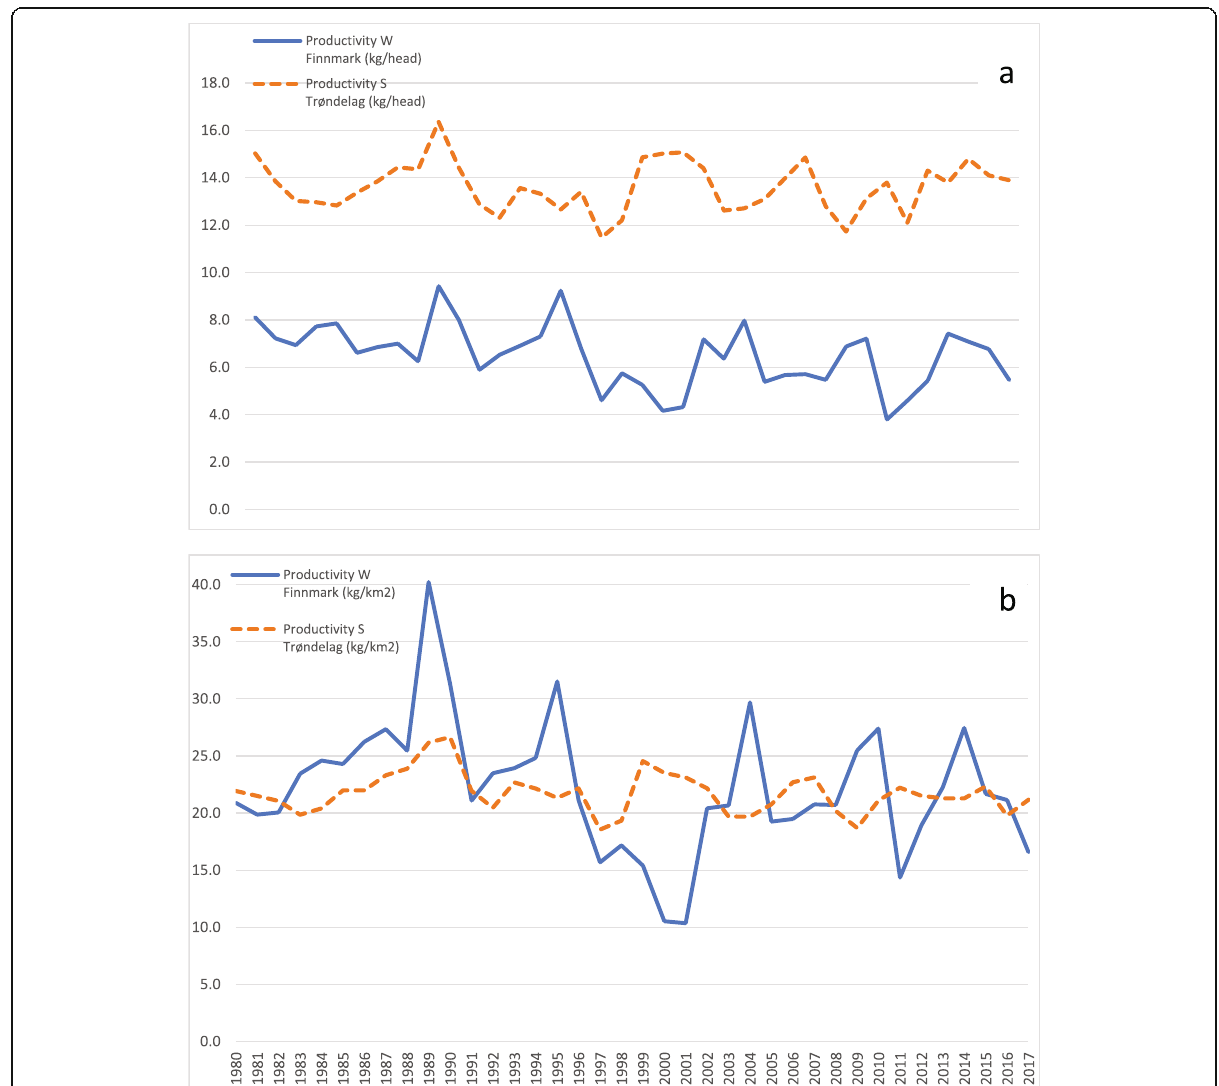
Fig. 7 a , b Productivity in the regions of Western Finnmark and South Trøndelag measured as A) kilogrammes per head of reindeer at the start of the year (1 April) and B) kilogrammes per square kilometre (data sources: MAF, Resurssregnskapet 2016/2017,